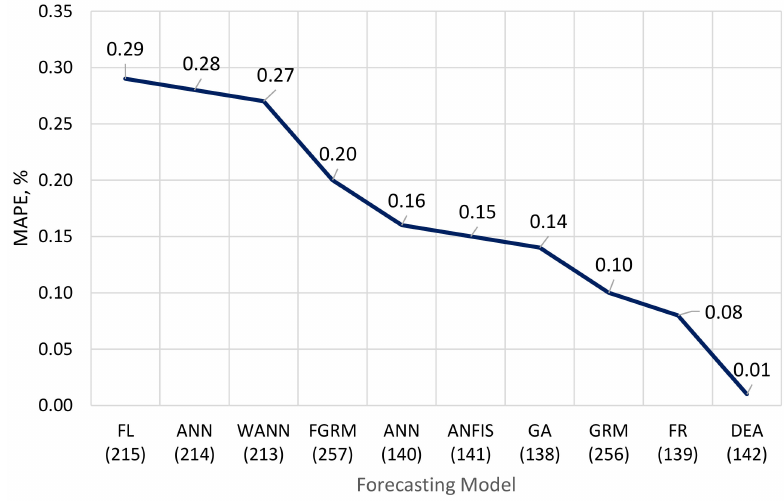
Figure 2. The effectiveness of forecasting models in the Top 10 set from a group of 264